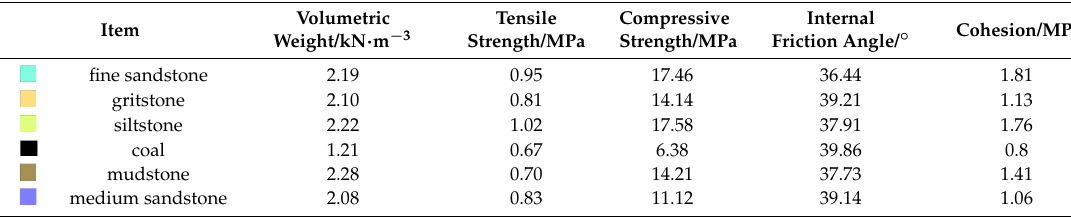
Figure 4. The UDEC model for ultra-thick seam coal mining. Table 1. Mechanical parameters of coal and rock